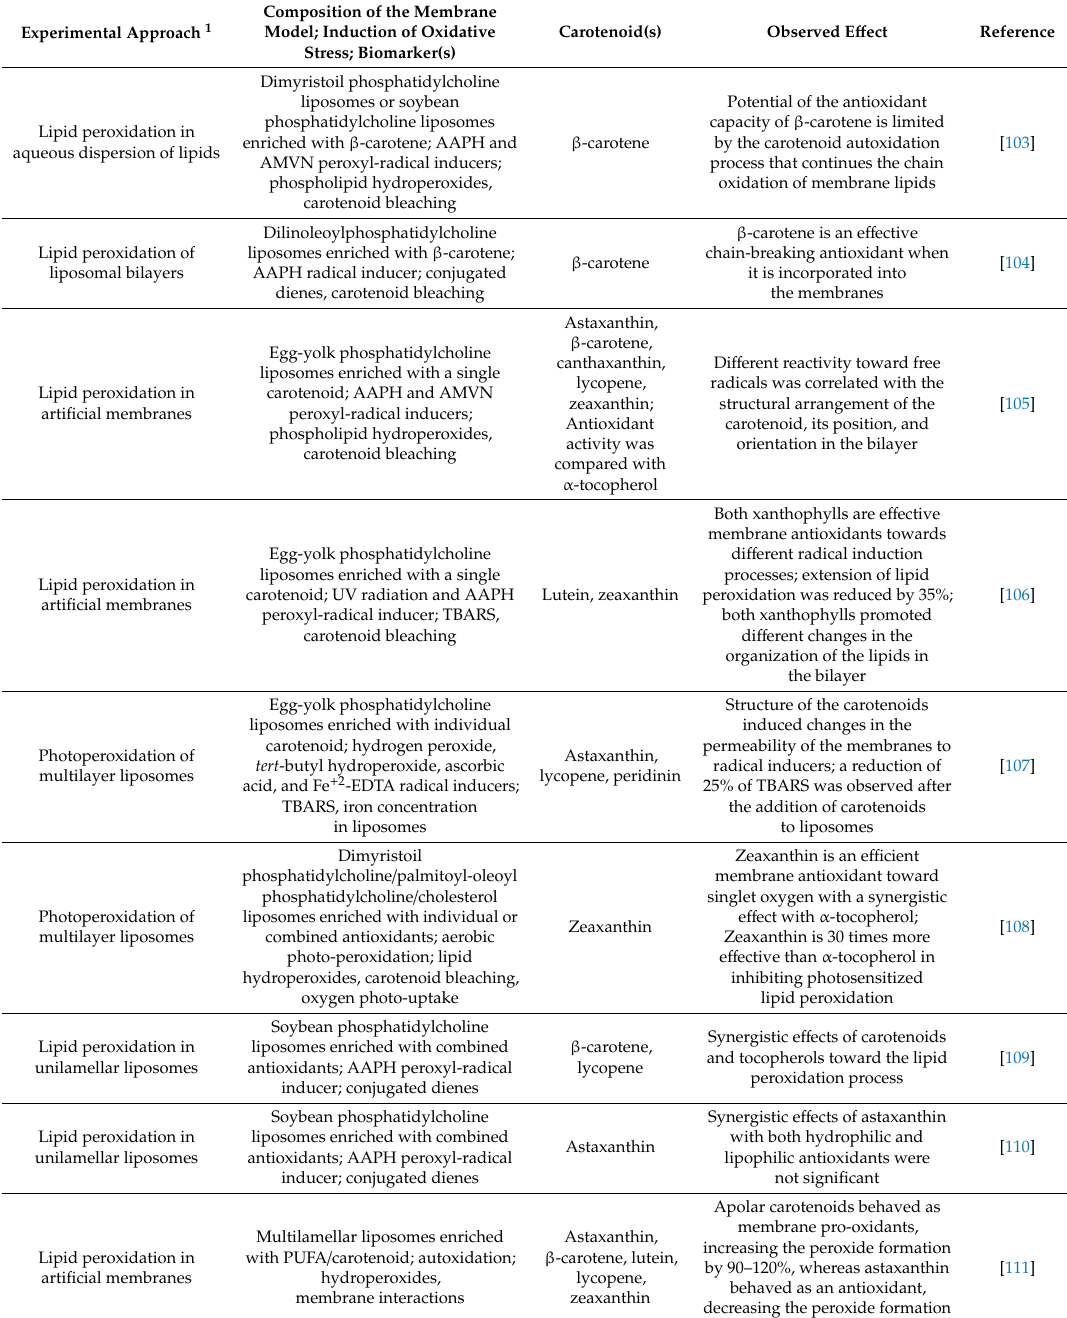
Table 3. Relevant studies considering the antioxidant capacity of carotenoids in liposomes. Experimental Approach